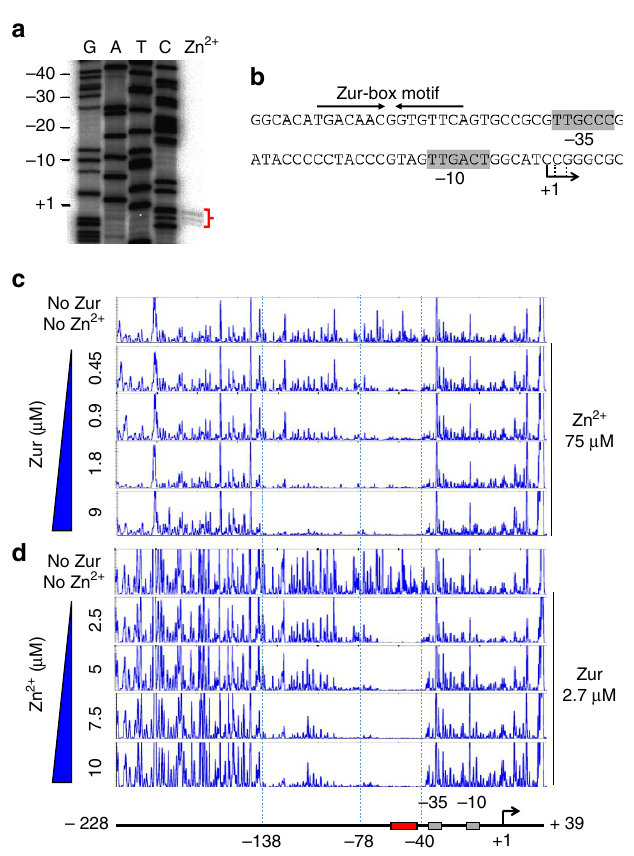
Figure 4 | Footprinting analysis of Zur binding to the zitB promoter region. ( a ) Determination of the zitB TSS by high-resolution S1 mapping. Exponentially grown cells were treated with ZnSO 4 at 100 m M for 1h before RNA preparation. The 5 0 end position of the zitB transcript ( þ 1) was determined by electrophoresis of S1-protected DNAs on a 6% polyacrylamide gel containing 7M urea, along with sequencing ladders generated with the SCC5F2A cosmid DNA and the same primer used to generate the S1 probe. The position of the longest protection was assigned as þ 1. ( b ) The positions of the predicted (cid:2) 10 and (cid:2) 35 elements of the zitB promoter and the Zur-box motif. ( c , d ) DNase I footprinting patterns of Zur- zitB DNA interaction as analysed by capillary electrophoresis. ( c ) Footprinting under varying Zur protein concentrations. The DNA probe containing the zitB gene from þ 39 to (cid:2) 228nt relative to the TSS ( þ 1) was incubated with increasing amounts of Zur (0.45, 0.9, 1.8 and 9.0 m M) in the presence of 75 m M ZnSO 4 . The DNA probe only with no added Zur nor zinc was analysed in parallel. The primary protection from (cid:2) 40 to (cid:2) 78, and the extended footprint at higher Zur up to (cid:2) 138 were indicated with dotted lines. ( d ) Footprinting under varying zinc concentrations. DNase I footprinting analysis was done with the same DNA probe, but with fixed amount of Zur at 2.7 m M, and increasing amount of ZnSO 4 (2.5, 5.0, 7.5 and 10.0 m M) in each binding reaction. Zinc-dependent extension of Zur footprint on the zitB promoter was